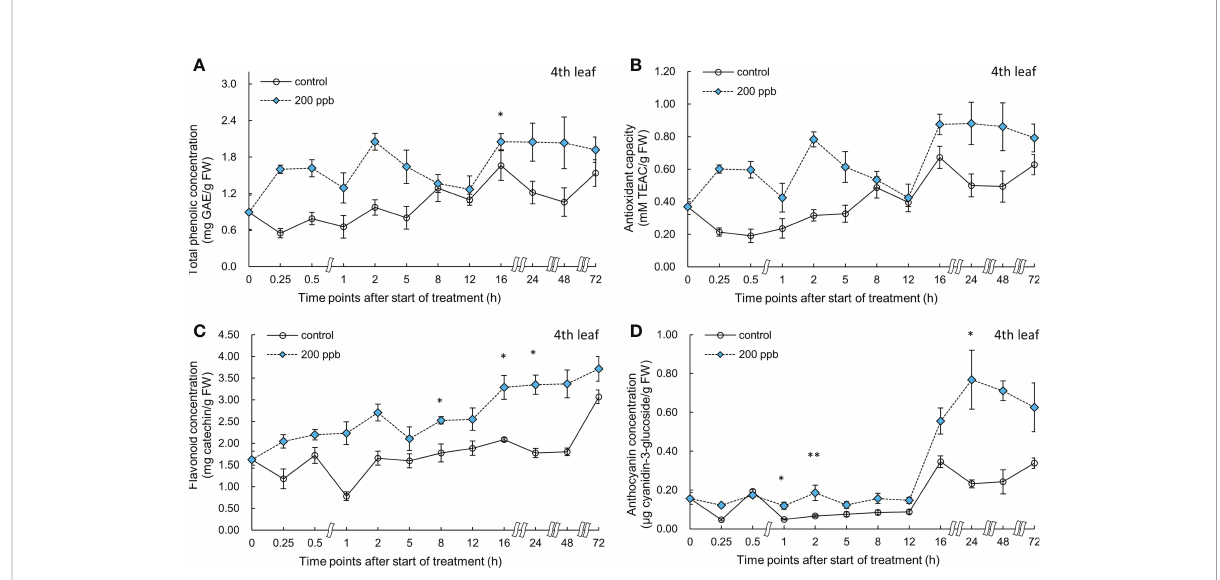
FIGURE 9 Total phenolic concentration (A) , antioxidant capacity (B) , total fl avonoid concentration (C) , and anthocyanin concentration (D) of fourth red leaf lettuce subjected to 200-ppb ozone treatment for 72 h. The vertical vars indicate SE (n=4). Statistically signi fi cant differences are indicated at * p < 0.05 and ** p < 0.01 by T-test.